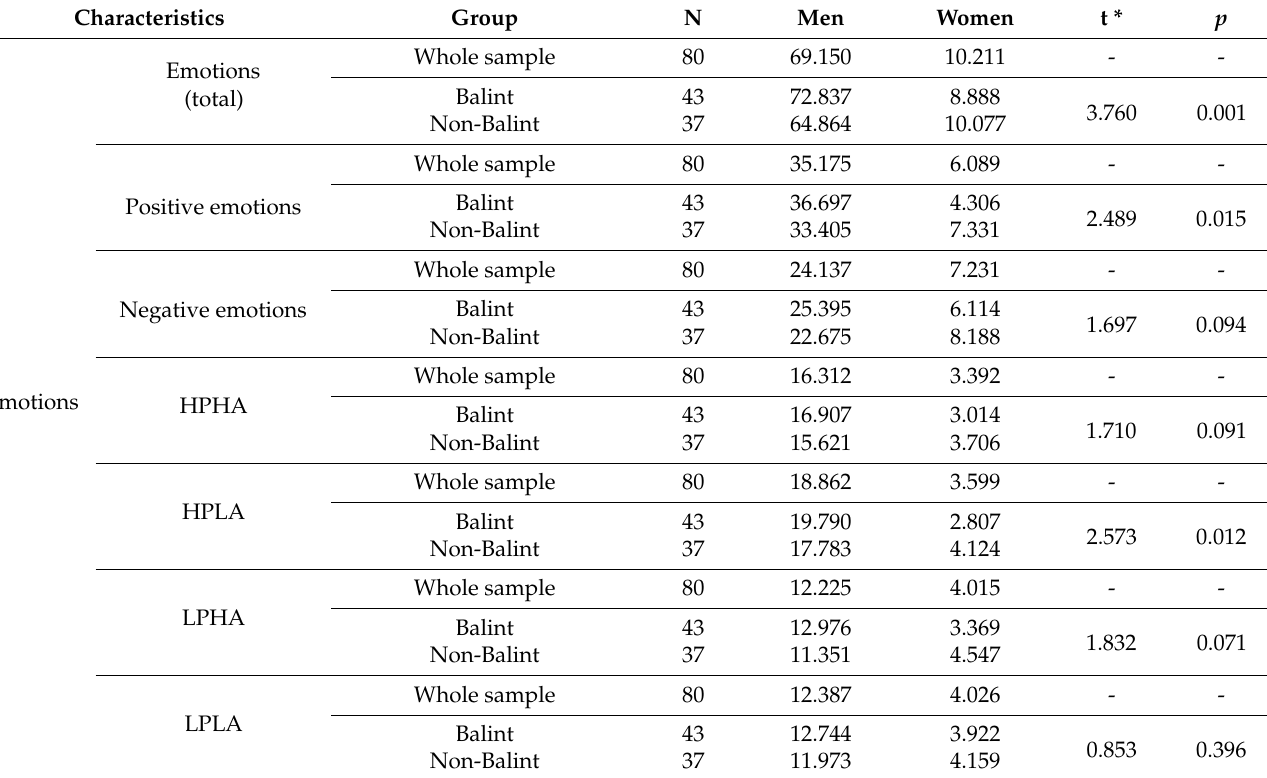
Table 2. Scores of the study variables and differences between